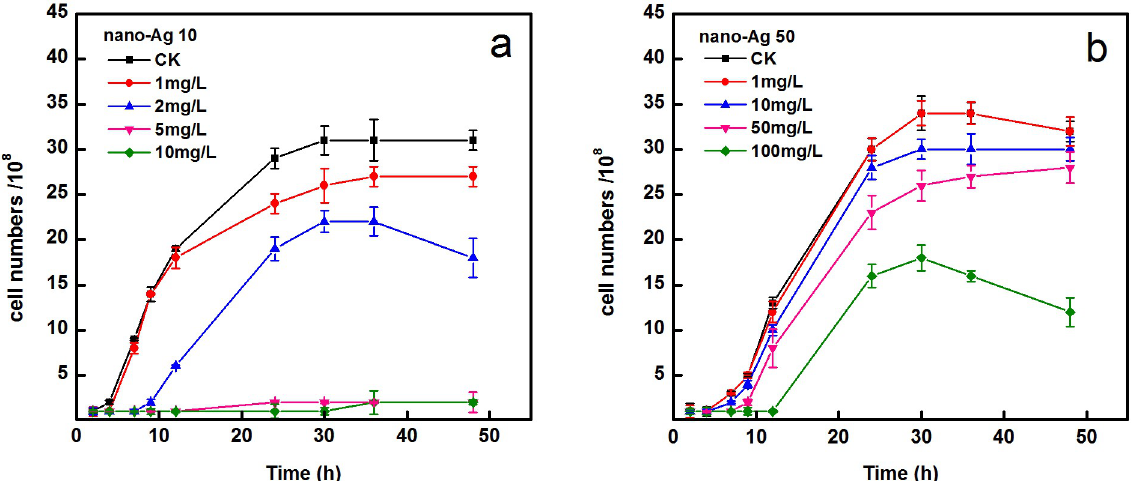
Fig 2. Effect of two different sizes of AgNPs on the growth of A . vinelandii . (a) nano-Ag 10 and (b) nano-Ag 50. The bacteria were cultured for 48 h in media with and without AgNPs.